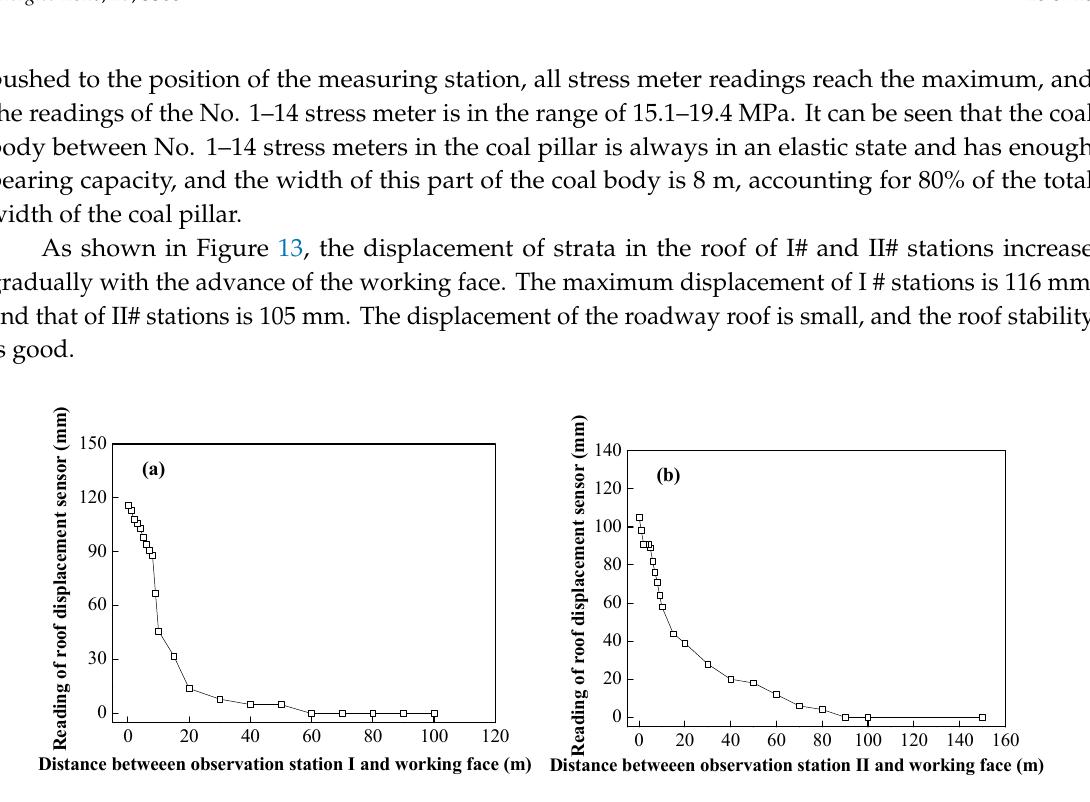
Figure 13. Relationship between the distance from the working face to the measuring station and roof displacement. ( a ) Relation curve between the distance from the Ⅰ # measuring station to the working face and roof displacement; ( b ) relation curve between the distance from the II # measuring station to the working face and roof displacement.